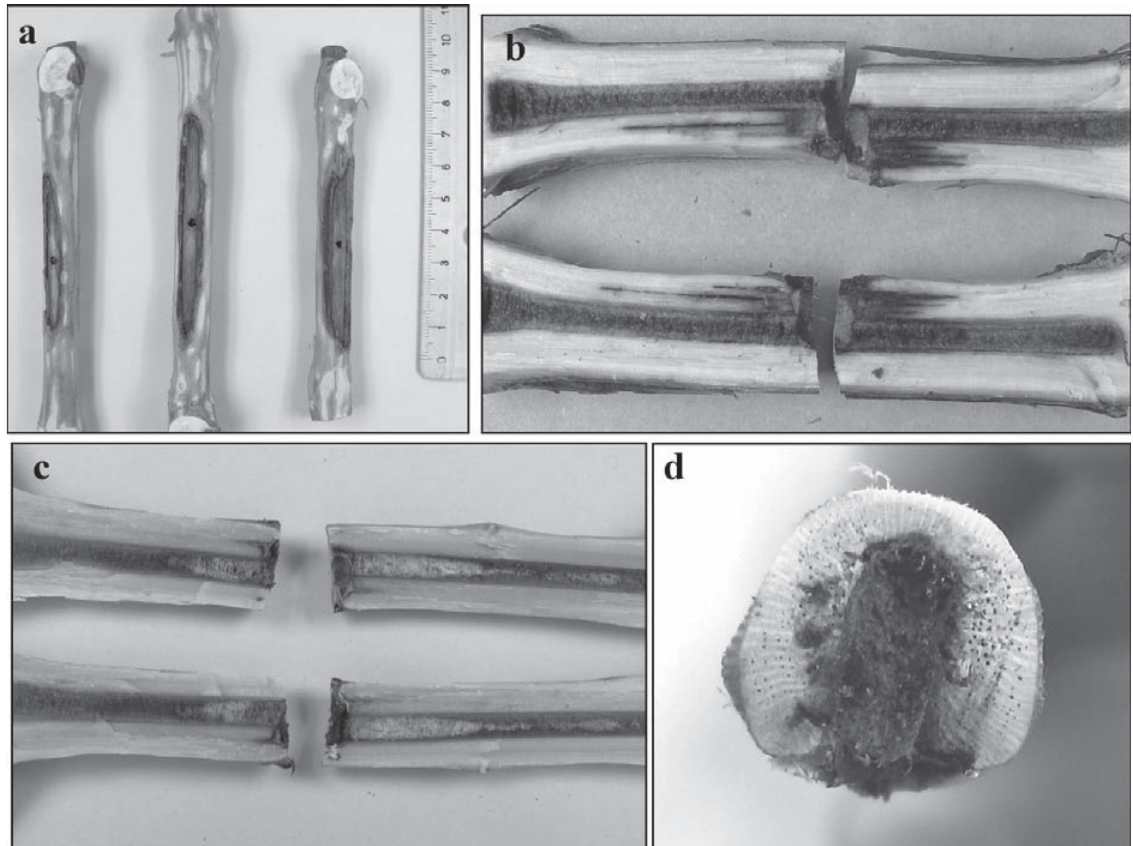
Fig. 1. Necrosis observed in wood of Cabernet Sauvignon cuttings. a, Neofusicoccum parvum cankers. b, Black streaks on longitudinal section following inoculation of Neofusicoccum parvum . c, Characteristic mycelium of Fo- mitiporia mediterranea into the pith on longitudinal section. d, Black spots on cross section following inoculation of Phaeomoniella chlamydospora